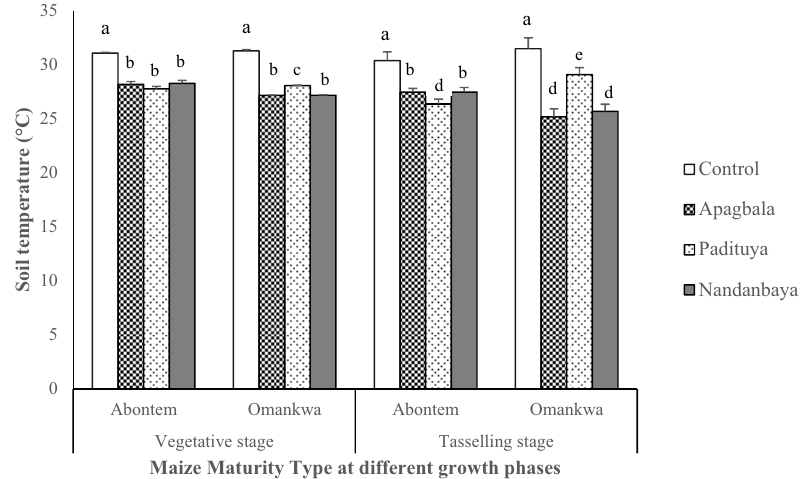
Figure 3: The interaction e ff ect of maize maturity type × cowpea living mulch type on soil temperature at vegetative and tasseling growth stage. Bars represent standard error of means and bars with di ff erent letters are signi fi cantly ( p < 0.05 ) di ff